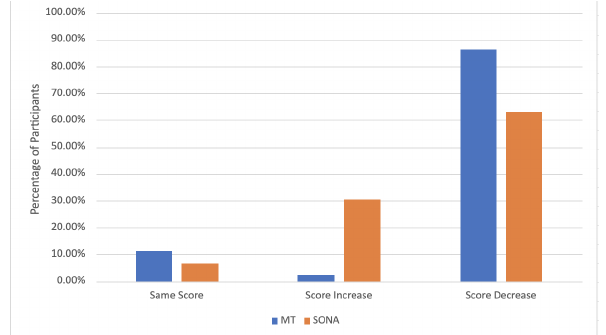
Figure 17. Differences in participants’ HAIS-Q scores in Part 1 and Part